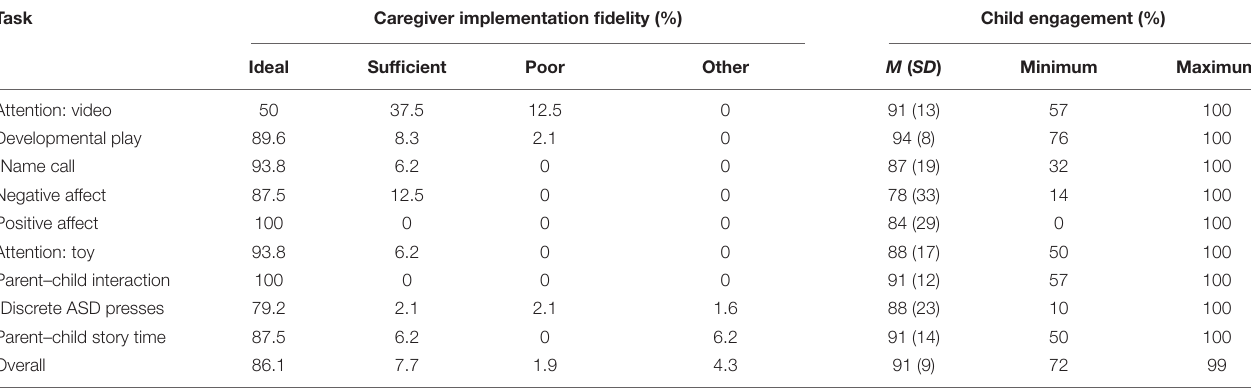
TABLE 4 | Caregiver implementation fidelity and child